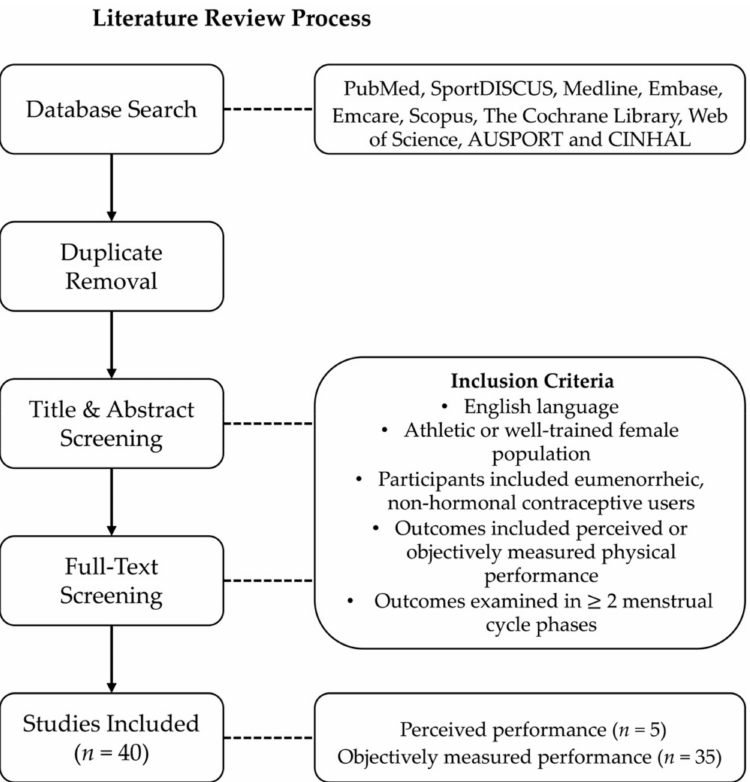
Figure A1. Summary of the search and screening methods implemented in this narrative